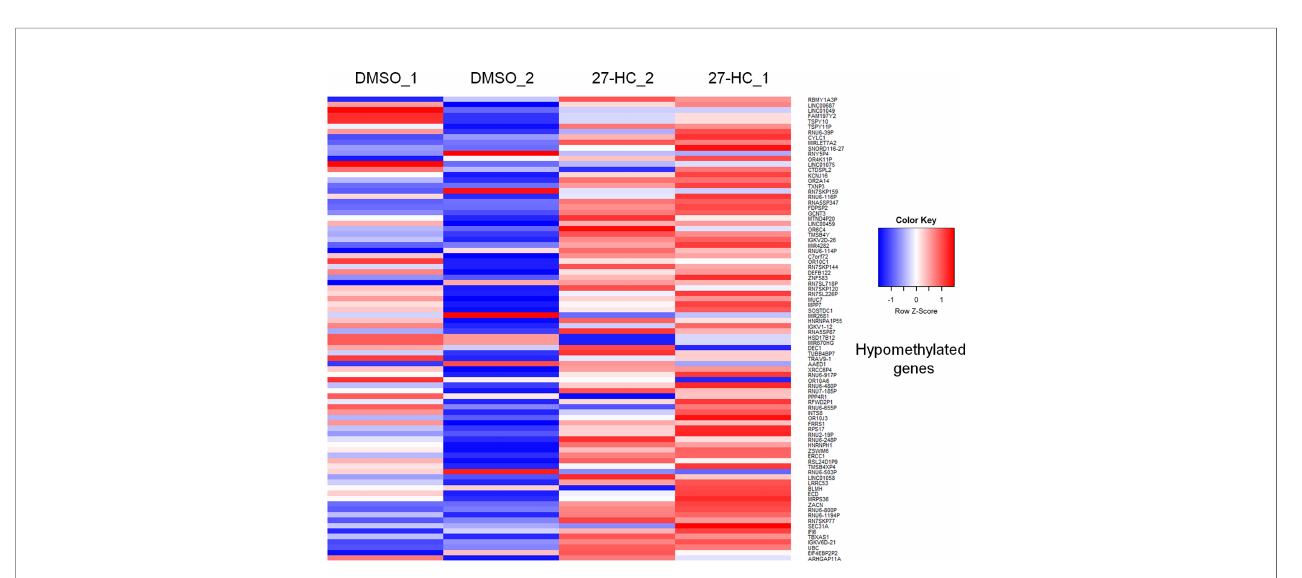
FIGURE 2 | The heatmap represents the hypomethylation in 27-HC treated samples. The heatmaps were generated using beta values obtained from fl uorescence intensity from the array scanning and the genes are considered hypomethylated when beta values are lesser than 0.5 (treated < 0.5 compared to